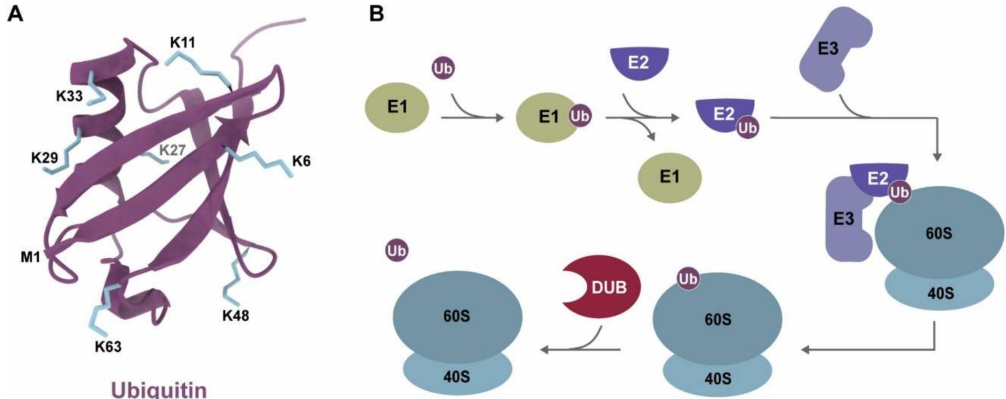
Figure 1. Ubiquitin and overview of the process of ubiquitination. ( A ) Structure of ubiquitin and the position of its lysine residues. The variety of roles for ubiquitin is in part mediated by the seven lysine residues (K) and the amino group of the first methionine residue (M1), where ubiquitin can form further polyubiquitin linkages. ( B ) Summary of the ubiquitin enzymatic cascade, in which a target, such as ribosomal proteins, can be ubiquitinated by the sequential functions of E1 activating enzyme, E2 conjugating enzymes, and E3 ligases. Ubiquitin modifications can lead to signaling functions or be reversed by deubiquitinating enzymes (DUB)